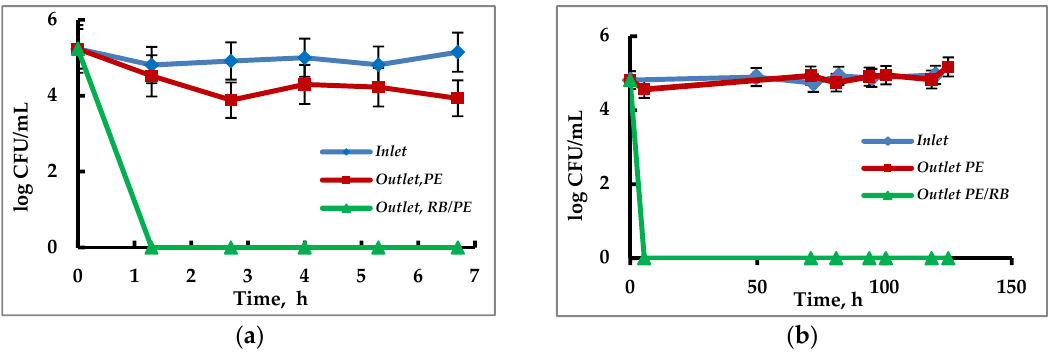
Figure 8. Results of continuous disinfection of water polluted with ( a ) S. aureus and ( b ) E. coli by 1% RB/PE under illumination with 1.25 mW/cm 2 white light.